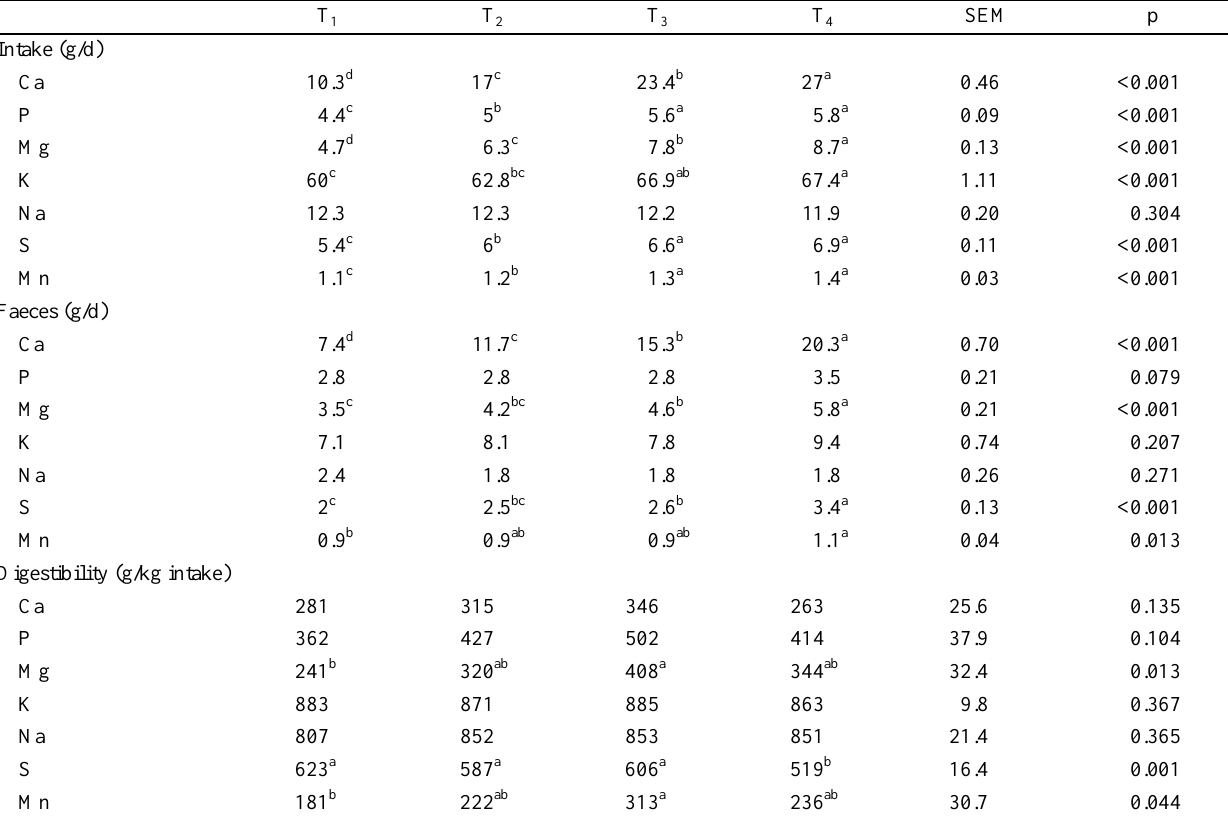
Table 3. Mean mineral intake, excretion to faeces and digestibility in cattle fed the four diets T